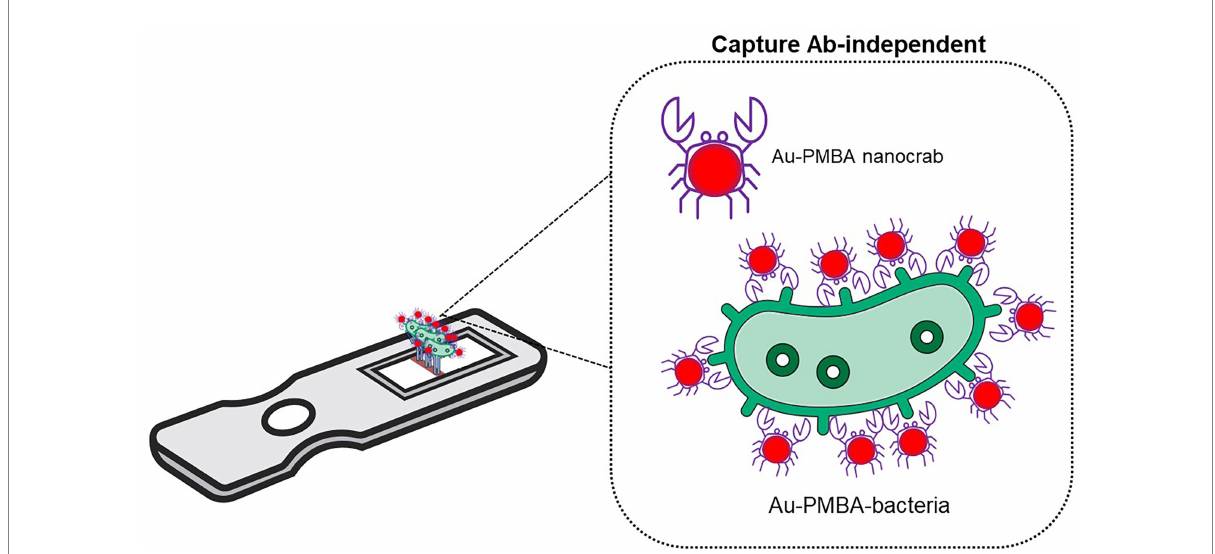
FIGURE 1 Lateral flow assay. A novel LFA with p-mercaptophenylboronic acid-modified AuNPs or “Au − PMBA nanocrabs” substituted the traditional LFA AuNP-labeled antibody (Wu et al.,